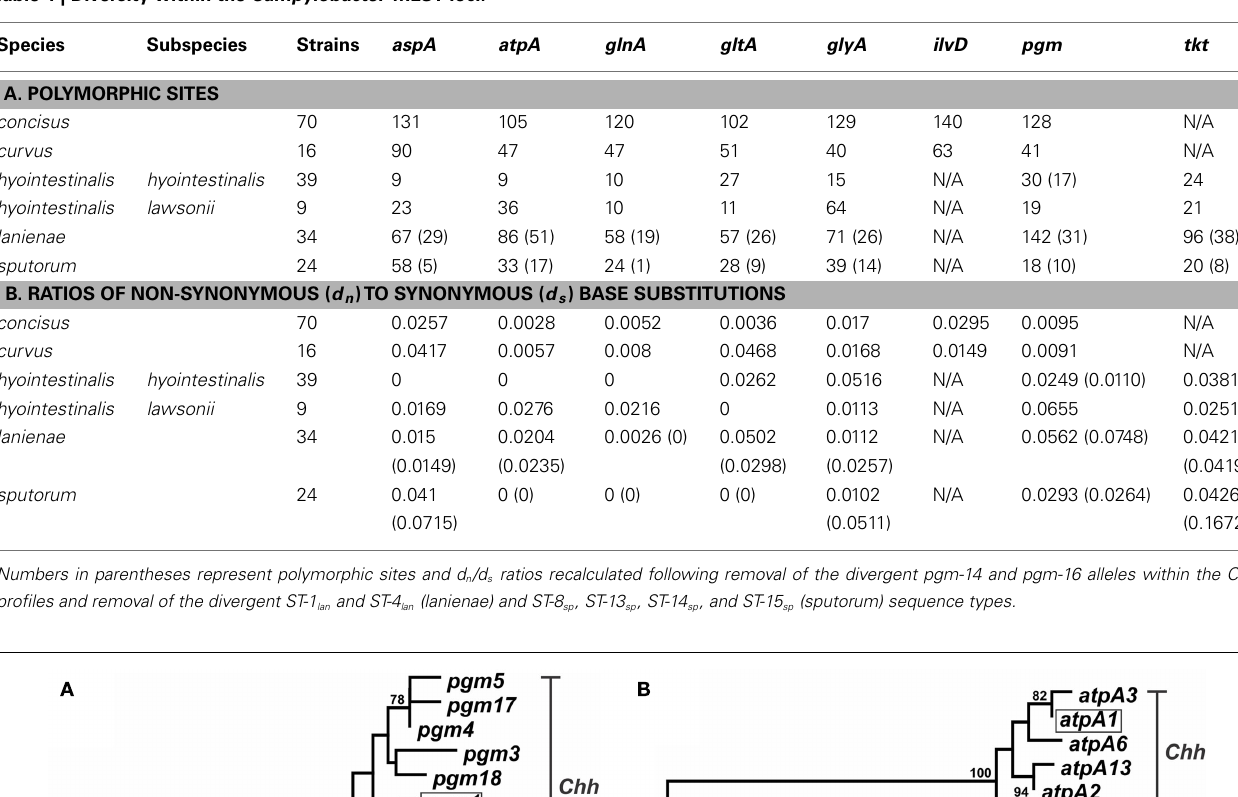
Table 4 | Diversity within the Campylobacter MLST loci.